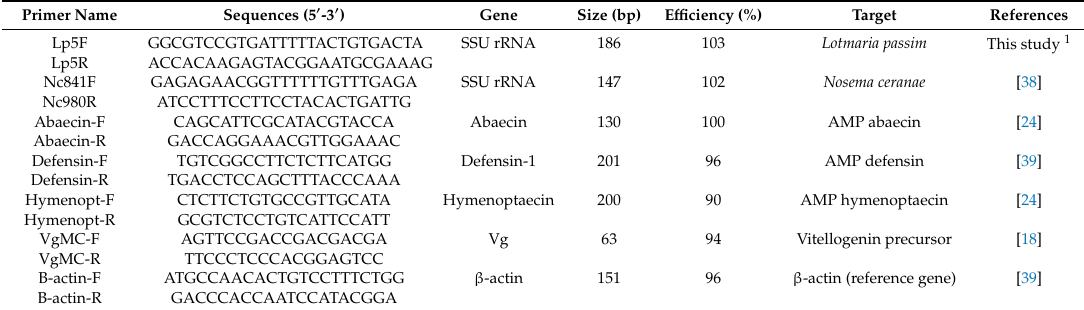
Table 1. List of gene-specific primers used in the real-time PCR (qPCR)